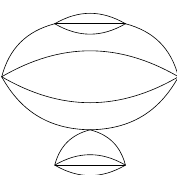
Figure 4 . A vacuum melon-tadpole Feynman diagram, where all the invariants have been shrunk to point-like